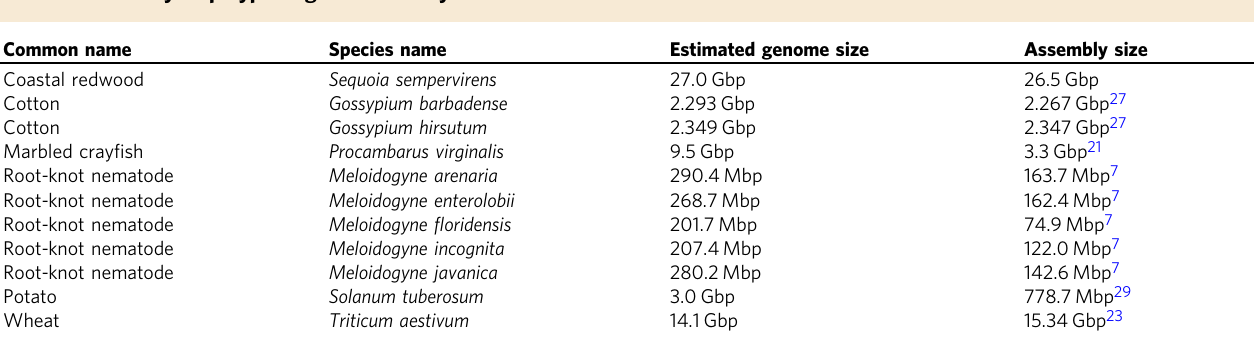
Table 2 Summary of polyploid genomes